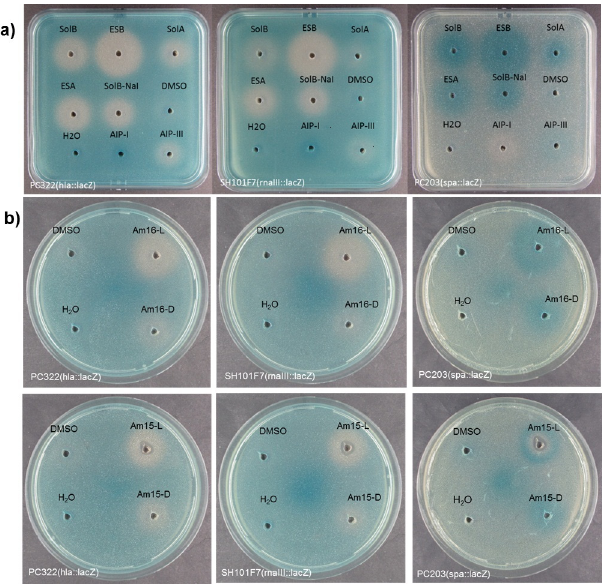
Fig 2. Biological validation of the synthetic solonamides (a) and lactam analogues (b). Agar plates containing the hla – lacZ (PC322), the rnaIII-lacZ (SH101F7) or spa – lacZ (PC203) reporter strains of S . aureus were exposed to DMSO (20 μ L) containing the test compound (0.5 mg/mL). Vehicle (DMSO), H 2 O, AIP-I (autologous) and AIP-III (heterologous) were used as controls. Virulence gene down-regulation is represented by a white zone and up-regulation by a darker than background blue